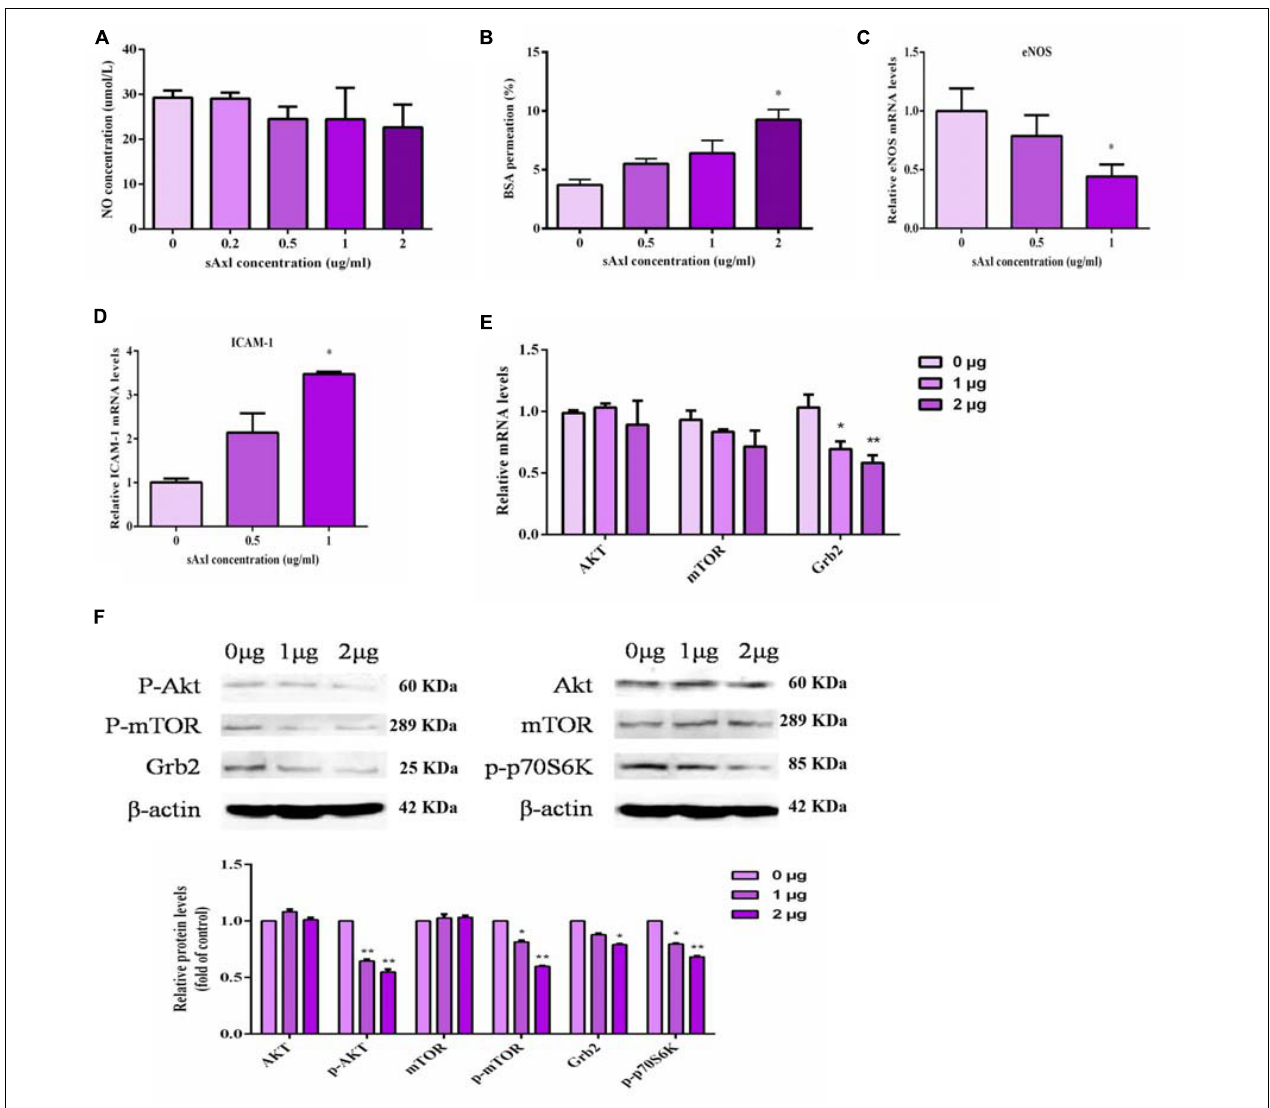
FIGURE 4 | Effects of sAxl on endothelial NO, eNOS, and ICAM-1. (A) NO level in medium supernatant after treatment with different sAxl levels. (B) BSA permeation. (C,D) mRNA expression of eNOS and ICAM-1. (E,F) The expression of signal molecules at different levels of sAxl at different times. The results are presented as mean ± SD. * p < 0.05, ** p < 0.01 vs. respective controls. n = 3 per